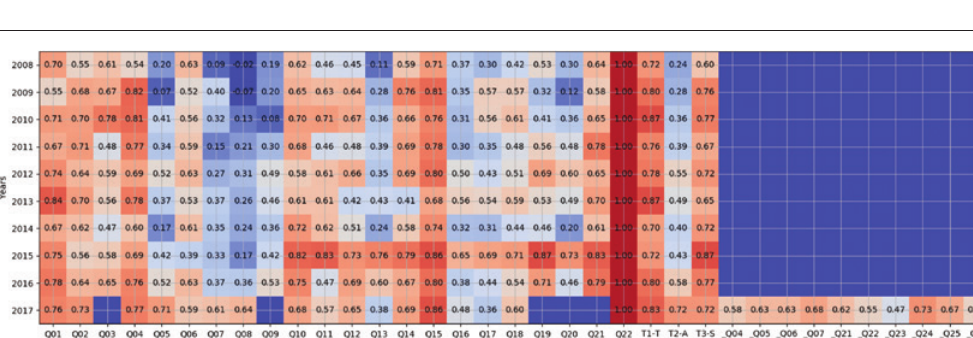
Figure 3: Heat-map of correlations of satisfaction of NSS questions with Q22, in computer science, per year, across the bottom half of providers by size